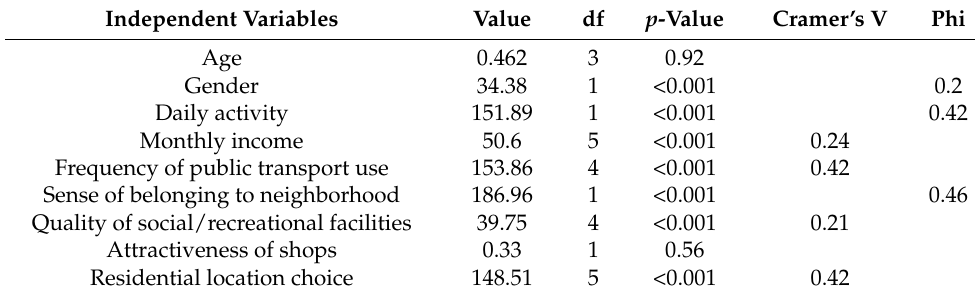
Table 4. Chi-square